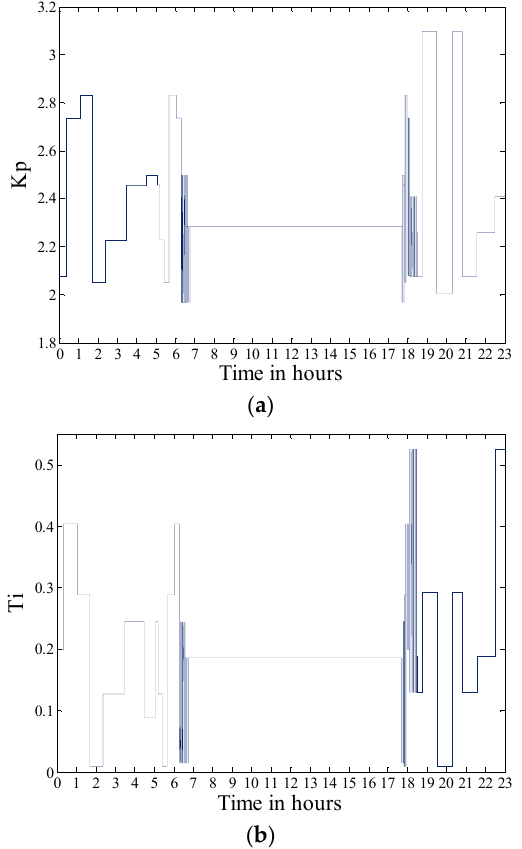
Figure 9. ( a , b ) show the variation of K p and T i respectively for different fuel cell controller set points using the simplex method.